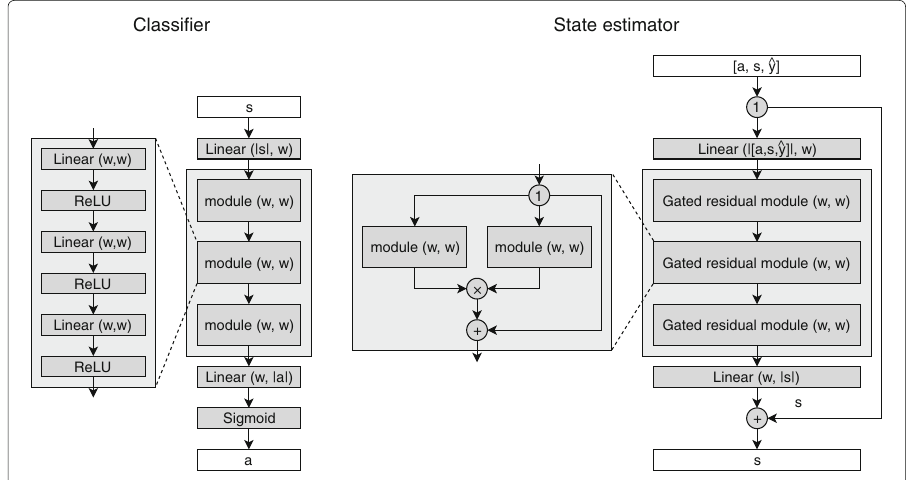
Fig. 4 Structure of the evaluated ANNs for the classifier and stateestimator . The numbers in parentheses define the number of elements in the input and output vectors, where | · | is the number of elements in the state s , one-hot encoded action a and forecast ˆ y . Linear layers are linear functions with a bias. ReLU and Sigmoid are non-linear activation functions. The symbols × and + are the elementwise multiplication and addition, and 1 stands for the